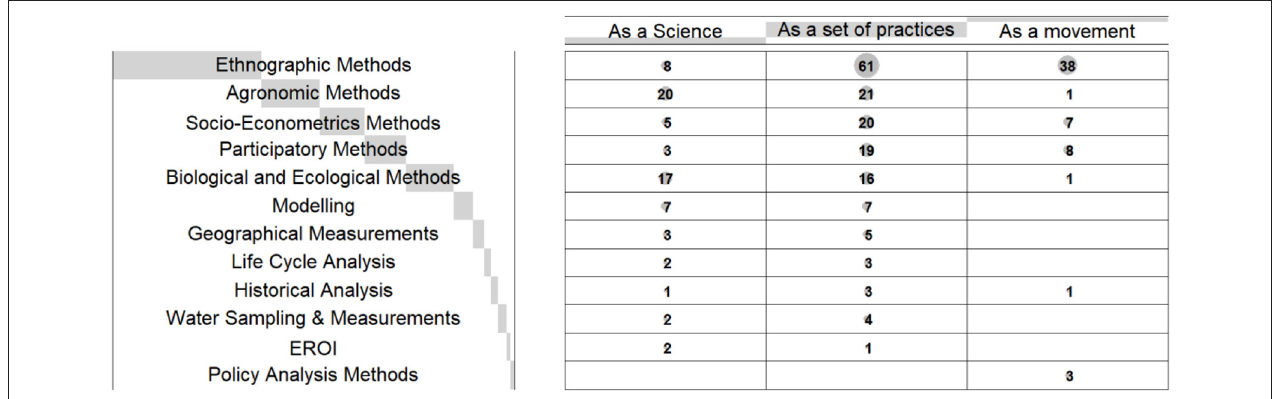
FIGURE 5 | Distribution of case studies according to the type of methods applied and the field of agroecology conceptualized. The gray bar in column and row labels represents the